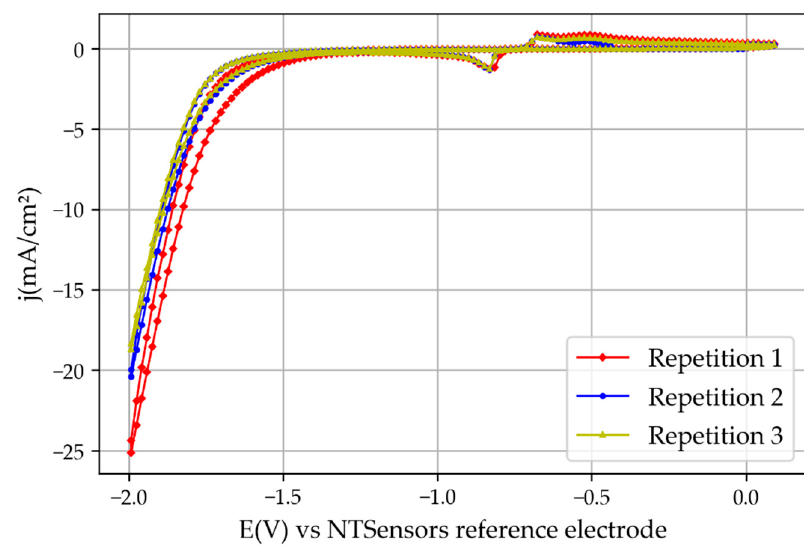
Figure 6. Cyclic voltammetry results obtained with the 3D printed reactor.